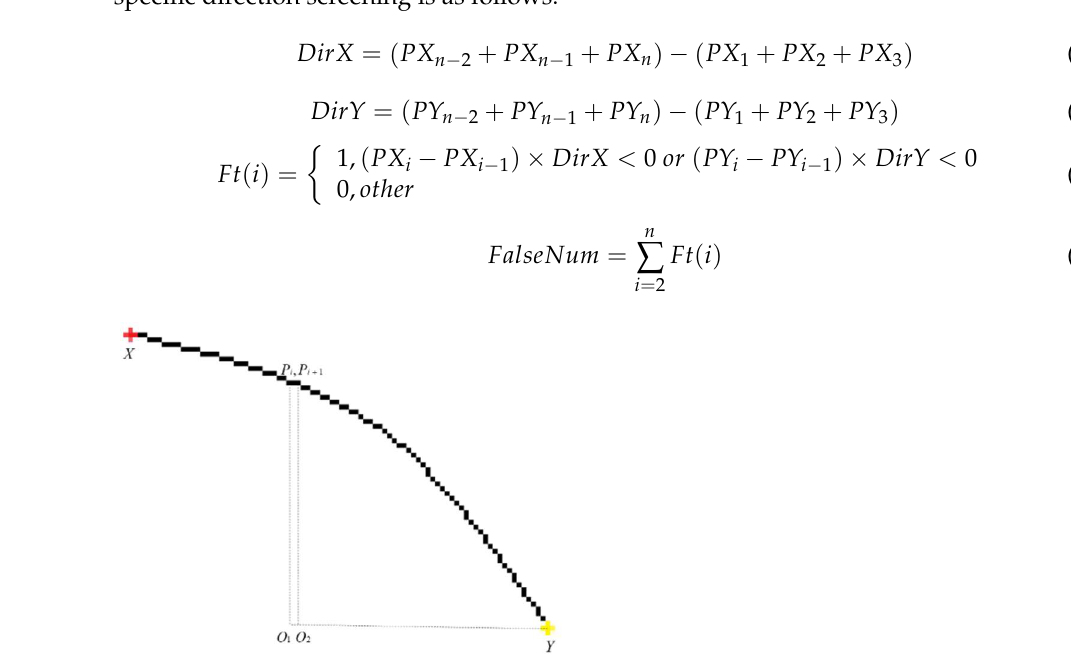
Figure 3. The distribution of information points on the image, where ‘*‘ represents information point calculation parameters, and ‘+‘ represents information point verification parameters.